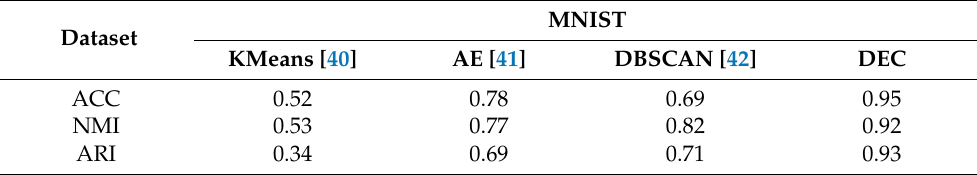
Table 1. Indicators for comparing different clustering algorithms on MNIST dataset.